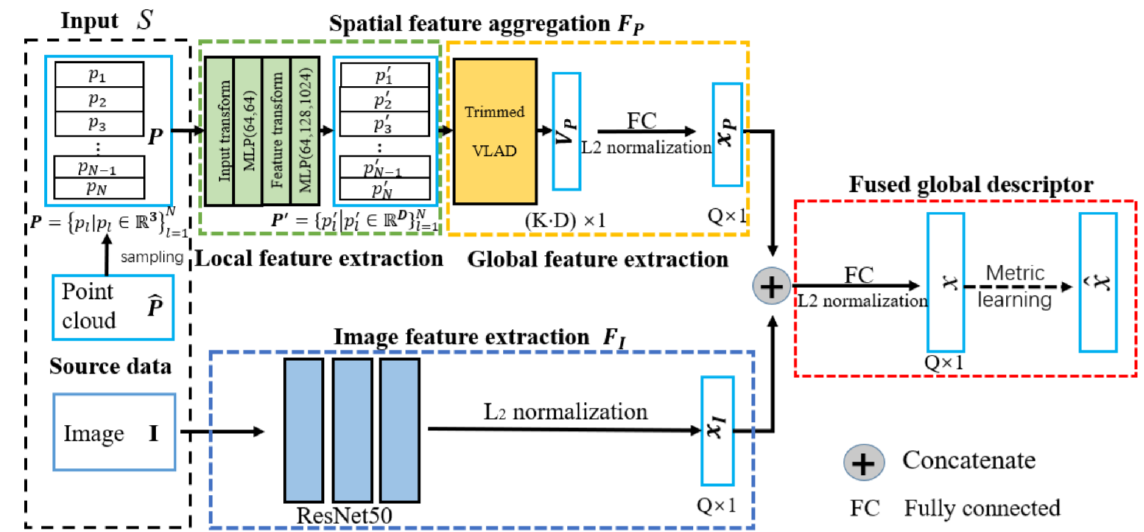
Figure 36. CNN based Camera-LiDAR Fused descriptor [88] for place